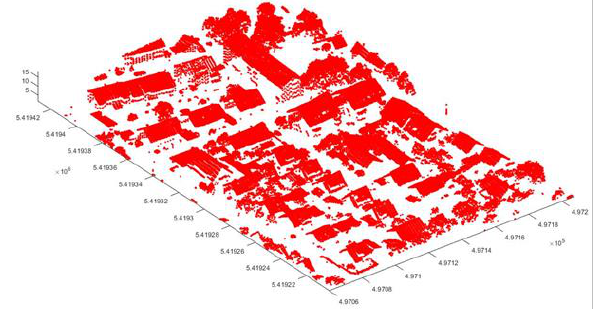
Figure 4. Dataset after elimination of points that belong to vertical objects such as: wall points